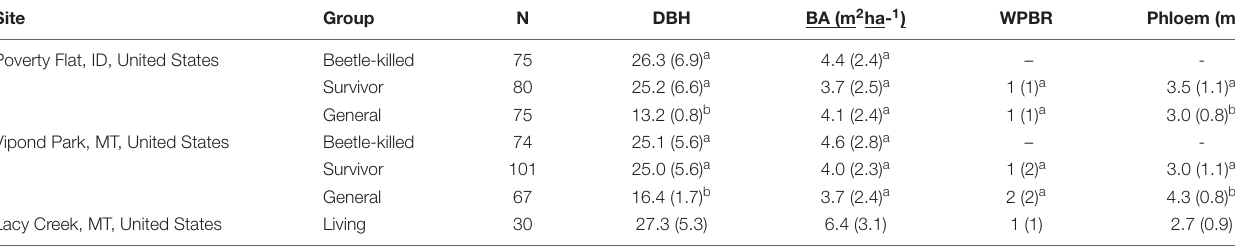
TABLE 1 | Summary statistics [mean (SD)] and comparisons for categories of Pinus albicaulis at the three sites sampled in this study. Site Group N Poverty Flat, ID, United